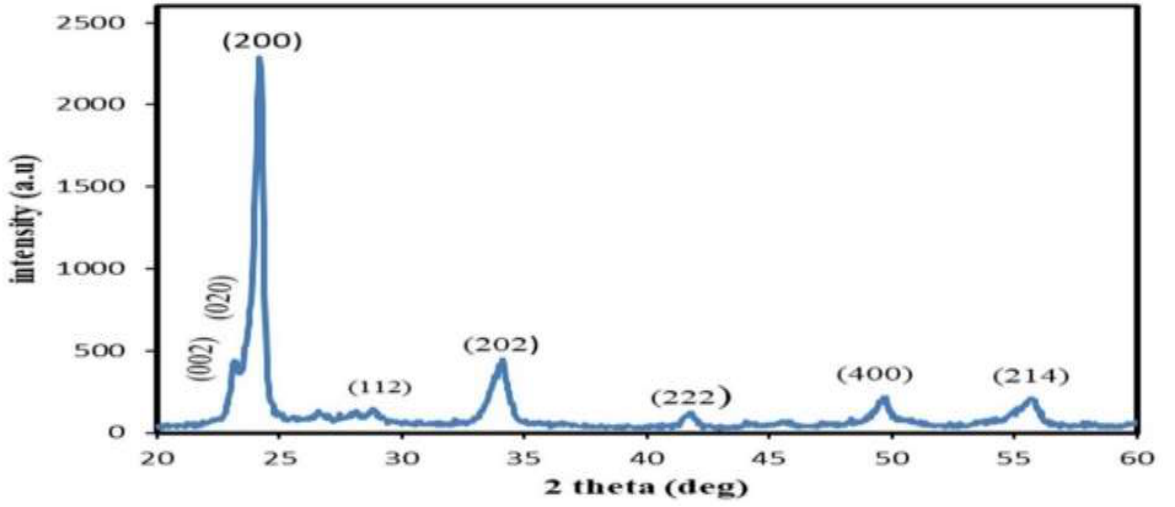
Figure 3: X-ray diffraction shapes of deposited WO 3 thin layer created utilizing spray pyrolysis process at optimal substrate temperature with molarity concentration of